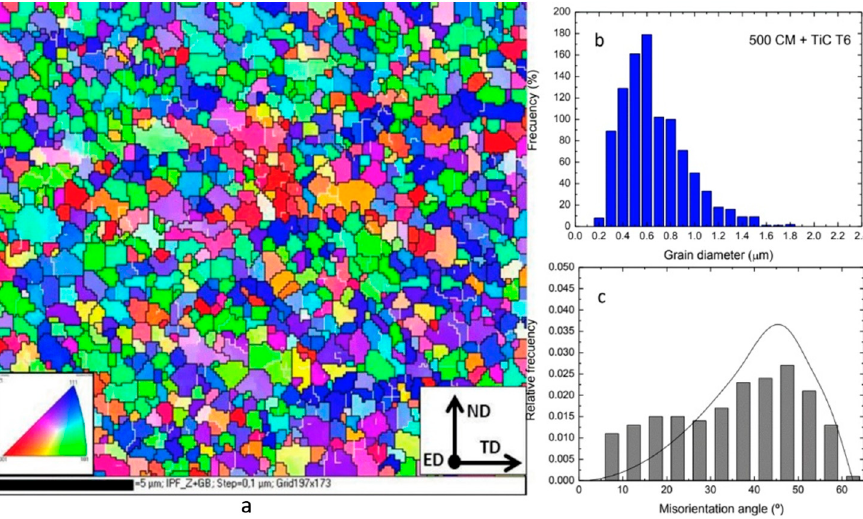
Figure 7. ( a ) EBSD Crystal Orientation Map (COM) with inverse pole key for cubic materials inset in the bottom left corner, ( b ) grain size distribution histogram, and ( c ) misorientation angle distribution histogram obtained from cross-sections of aluminium matrix of AlMNC-HEBM in the as-extruded condition. Different colours reflect the crystal lattice orientation positions in the Euler space. LAGBs and HAGBs are denoted by white and black lines, respectively.